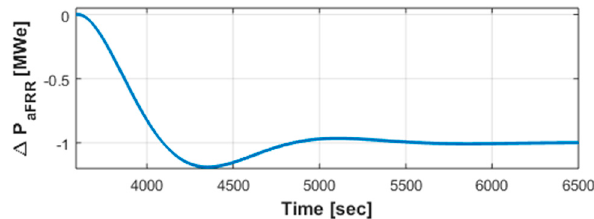
Figure 12. Example of synthetic aFRR activation signal from Transmission System Operator (TSO) control center based on [6].